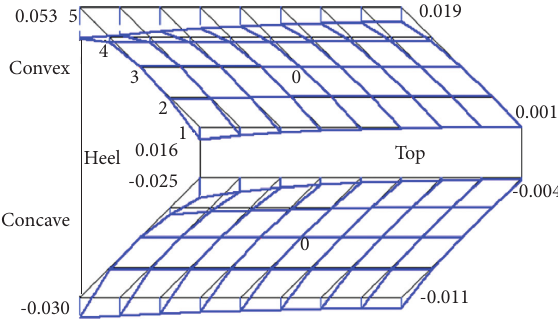
Figure 14: Analysis results of the tooth